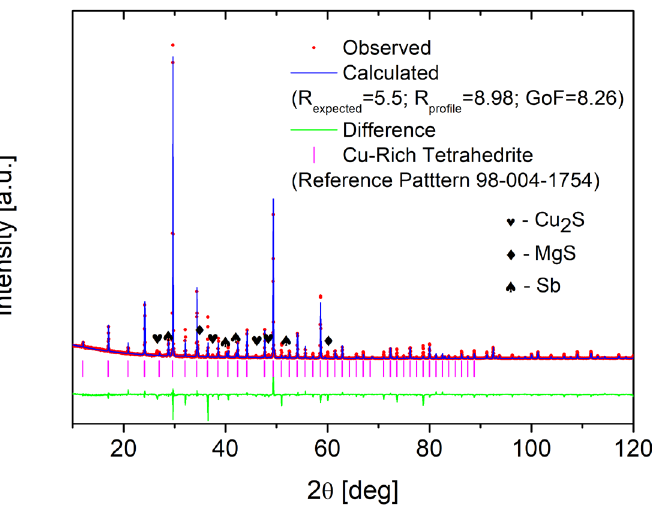
Figure 6. Example observed x-ray diffraction pattern with pattern calculated from Rietveld refinement for Mg 0.5 Cu 12 Sb 4 S 13 sintered sample.